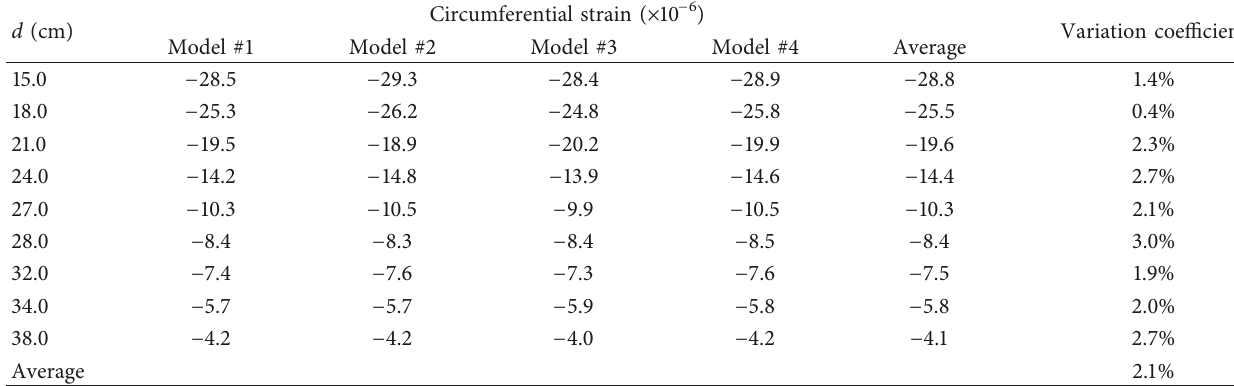
Table 5: Parallel test results of circumferential strain of the AC pavement structure model.